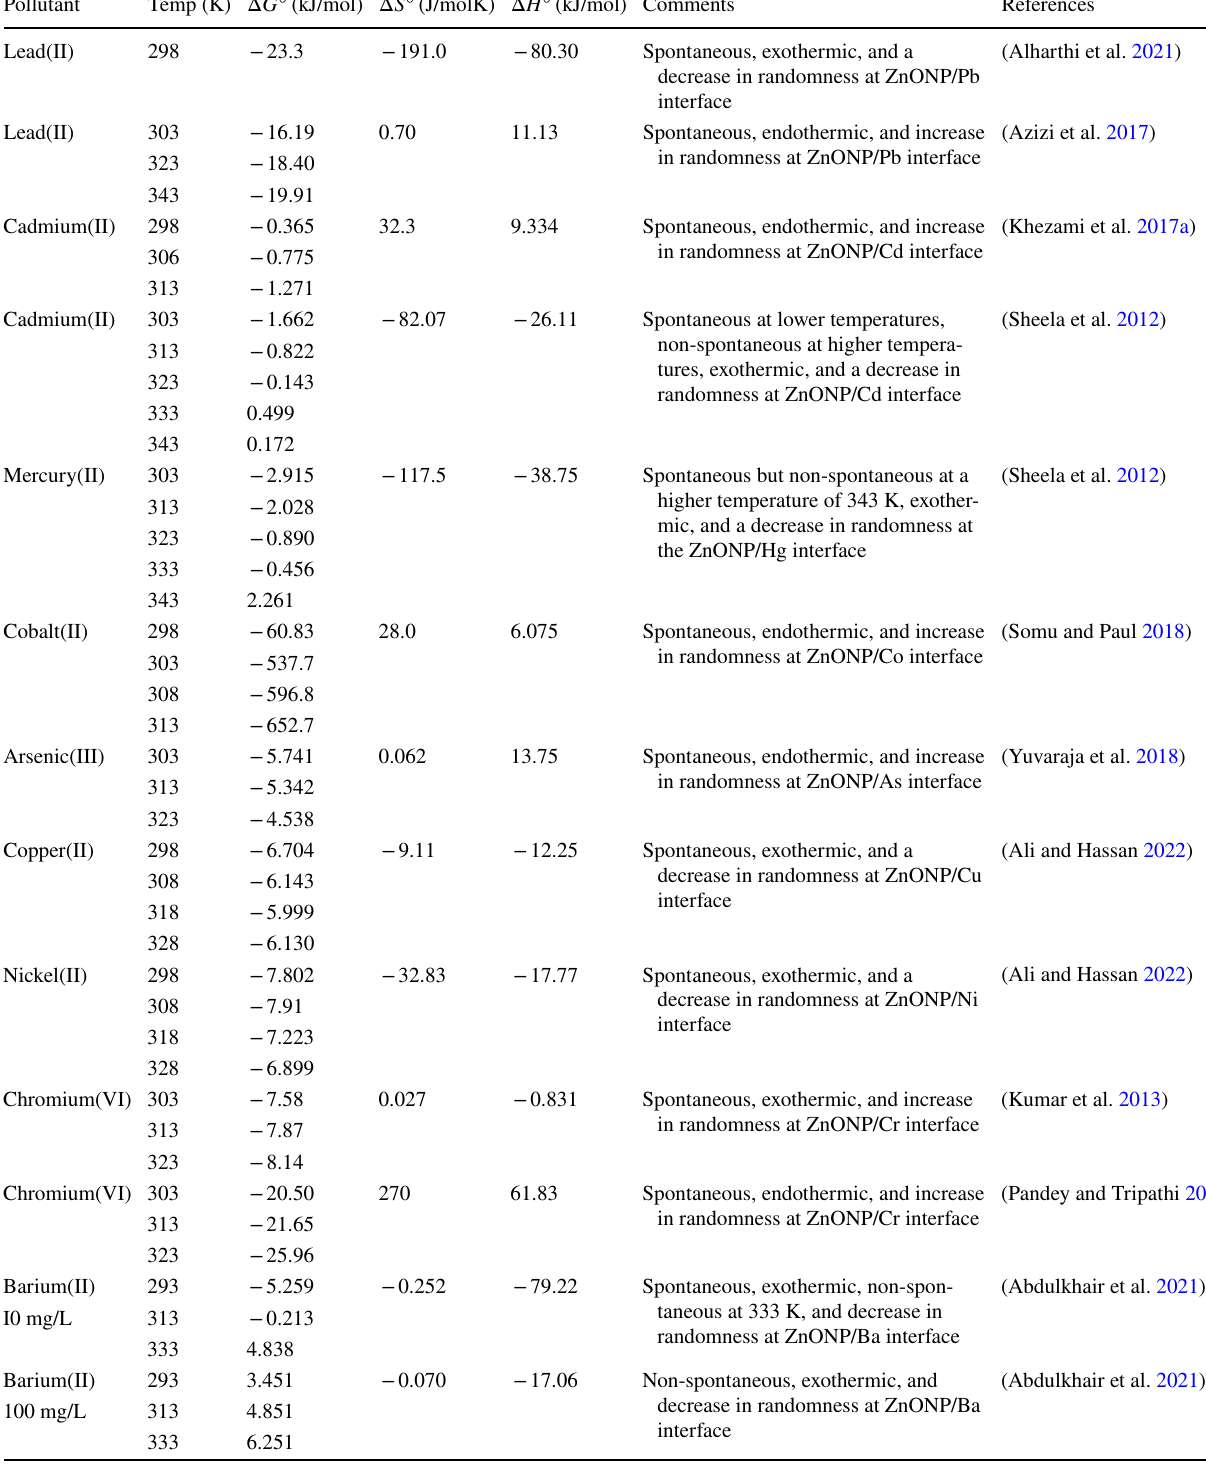
Table 5 Thermodynamic investigations on the adsorption of heavy metals and radionuclides onto ZnO nanoparticles